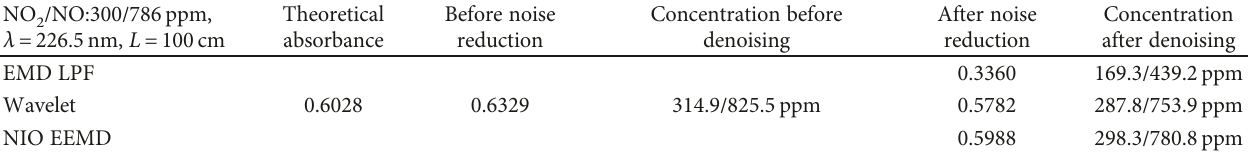
Table 4: Absorbance and inverted concentrations before and after noise reduction with three